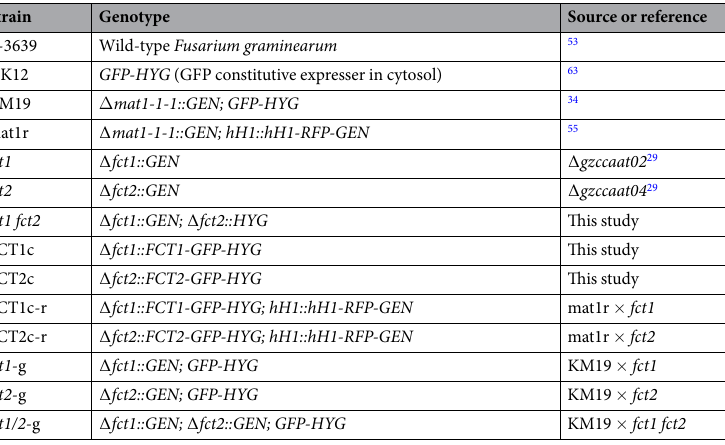
Table 1. F. graminearum strains used in this